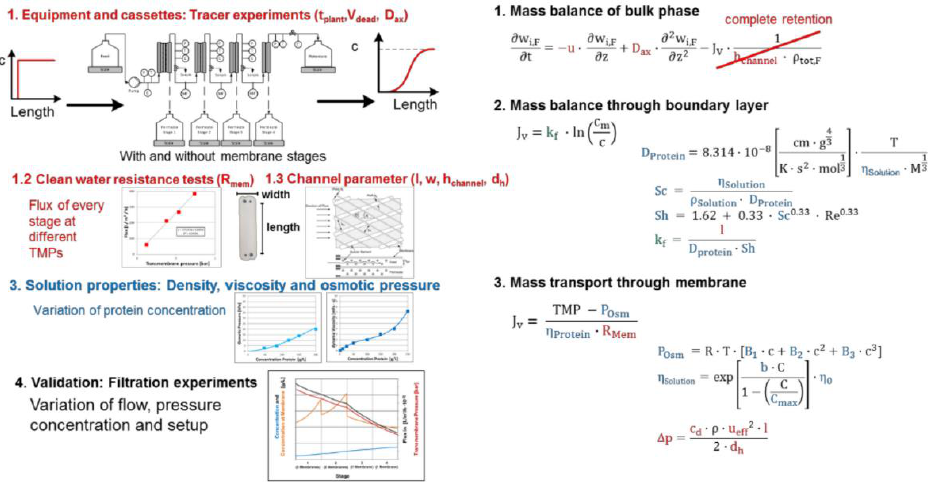
Figure 6. Workflow for process modelling of SPTFF [29].